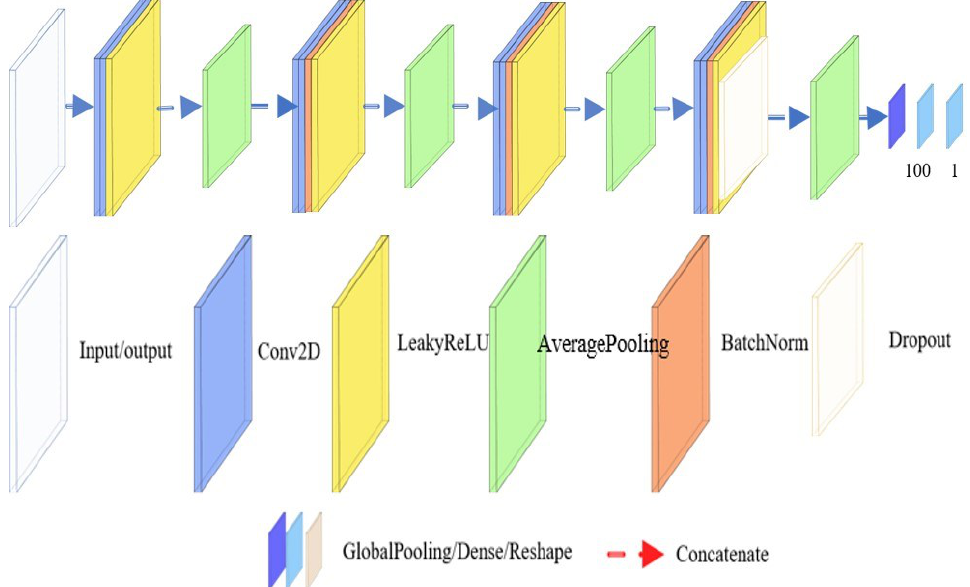
Figure 2. Discriminator